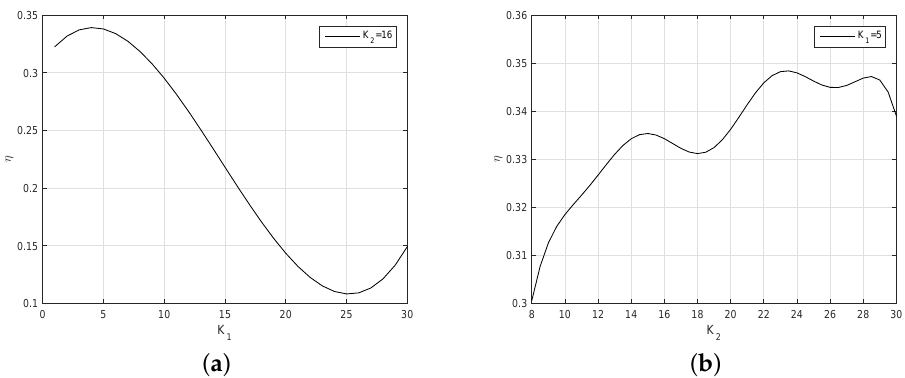
Figure 16. The efficiency of the robotic fish to K 1 and K 2 . ( a ) When K 2 = 16, the efficiency varies with K 1. ( b ) The changing of the efficiency along with the variation of K 2 .